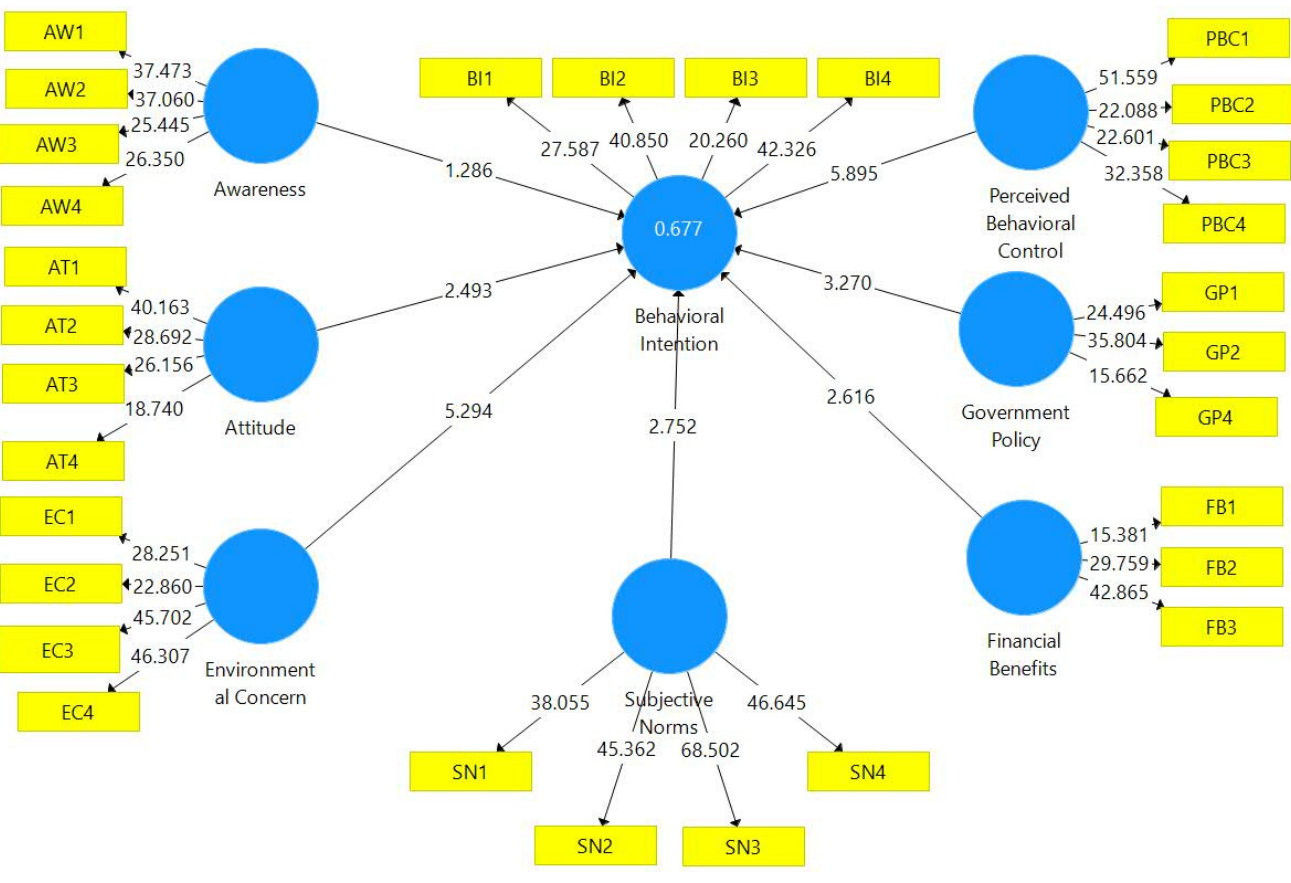
Figure 3. Structural Model. Table 8.